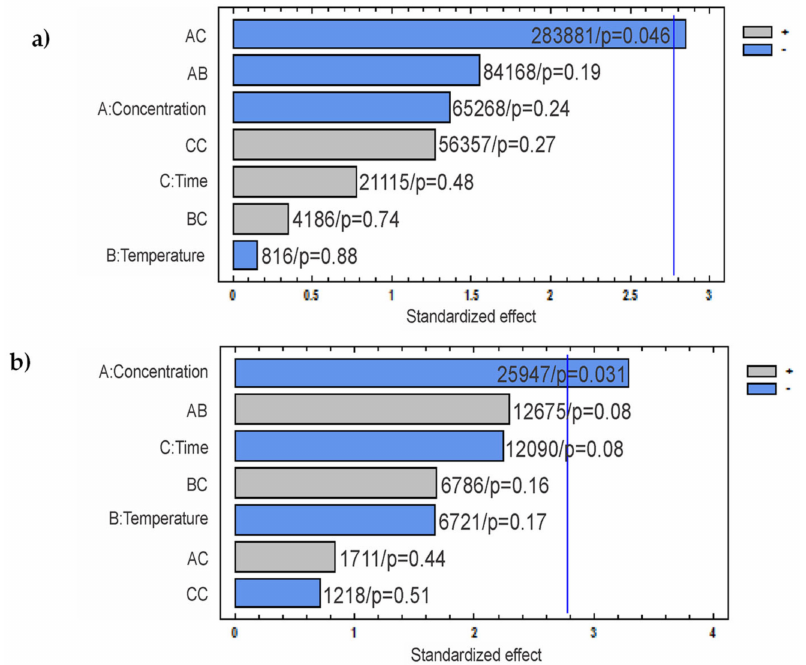
Figure 11. ( a ) Pareto standardized effect for CNC-H length measured by AFM; ( b ) Pareto standard- ized effect for CNC-S length measured by AFM. The sum of squares and p -value is shown at the right side of each